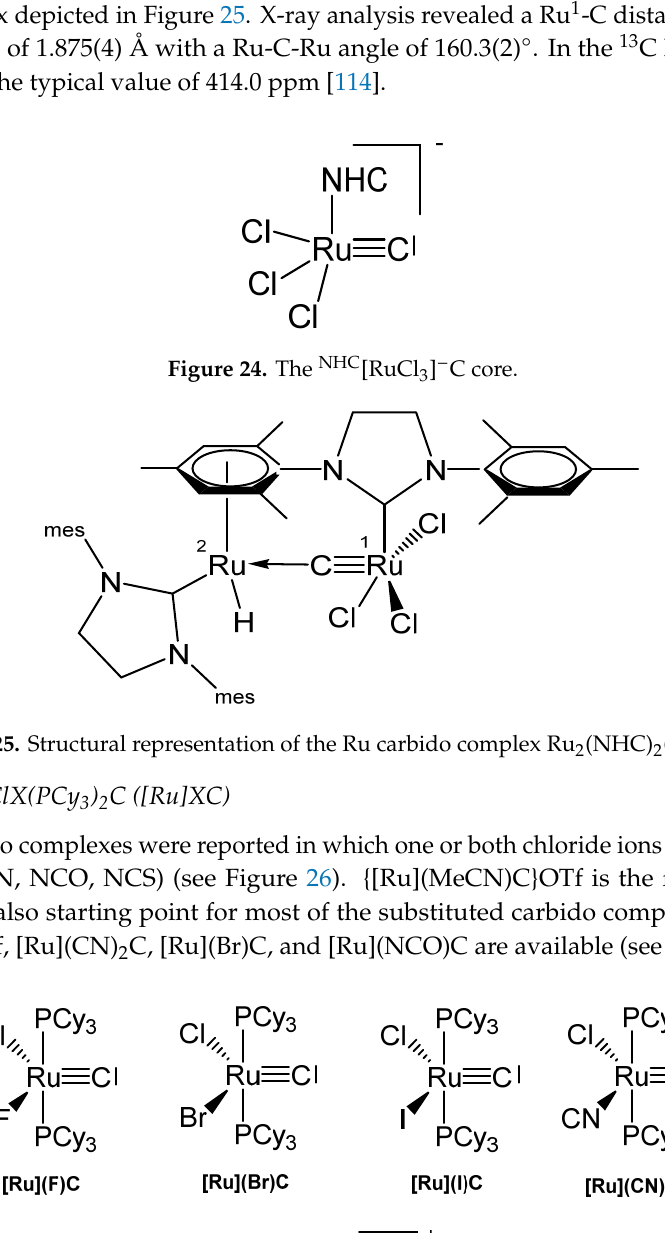
Figure 23. The NHC [Ru]C core.